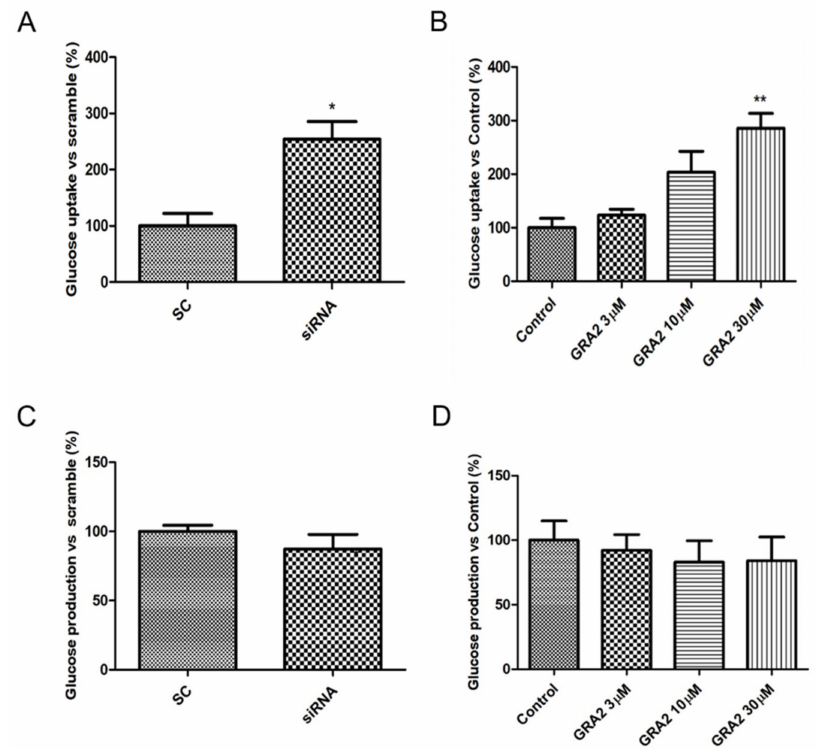
Figure 4. Effect of GPR21 gene silencing and GRA2 treatment on hepatic glucose homeostasis. Glucose uptake was assessed using a 2-NBDG fluorescent probe; HepG2 cells were transfected for 72 h with non-silencing siRNA (scramble, SC) or with specific siRNA against GPR21 (siRNA, panel ( A )) or exposed to increasing concentrations of inverse agonist GRA (3–30 µ M, 24 h, panel ( B )). Data are expressed as mean ± SEM ( n = 4) in % vs. control or scramble. * p < 0.05 vs. scramble control (SC); ** p < 0.01 vs. control. ( C , D ). Glucose production was evaluated on HepG2 cells transfected with non-silencing siRNA (SC) or with GPR21 siRNA ( C ) or exposed to increasing concentrations of inverse agonist GRA2 (3–30 µ M, 24 h, panel ( D )). Values are expressed in % vs. control or scramble. Data are expressed as mean ± SEM ( n = 3) in % vs. control or scramble.